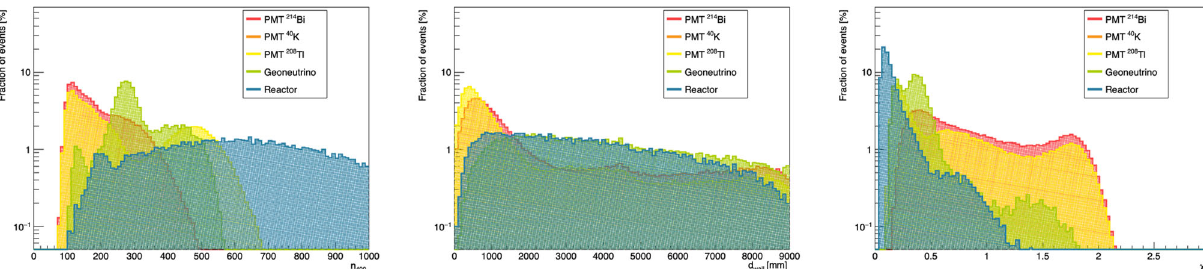
Fig. 5 PMT and signal event distributions of the characteristic parameters used in the BDT training: n 400 energy estimator (left), d wall distance (in mm) of the reconstructed event from the closest wall (middle), and χ 2 of the reconstruction fit